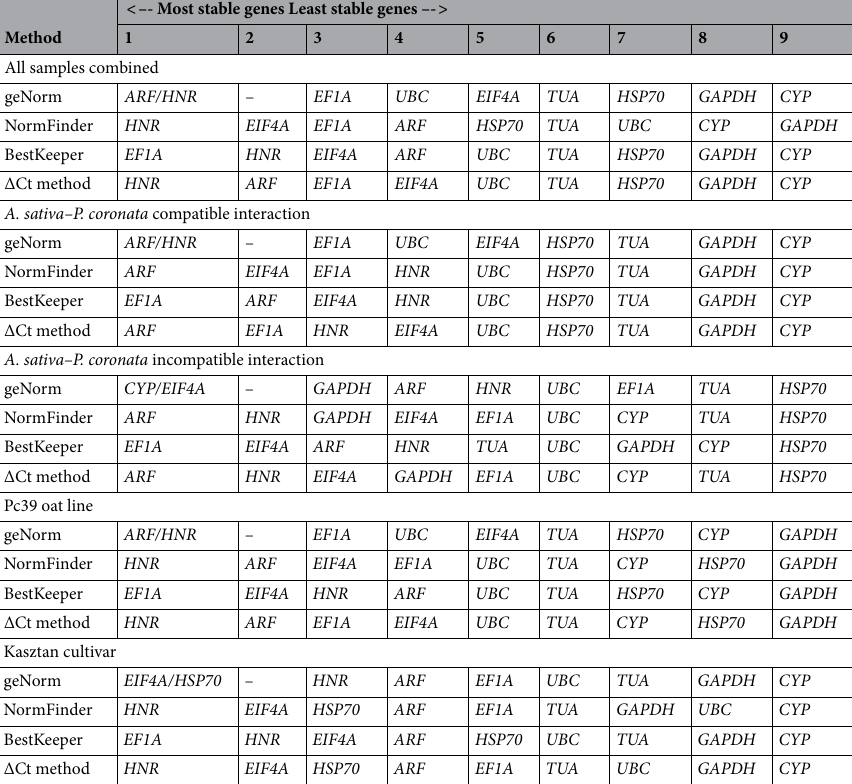
Table 3. Ranking of candidate RGs stability according to tested algorithms for whole A. sativa – P. coronata pathosystem and specific samples subgroups.